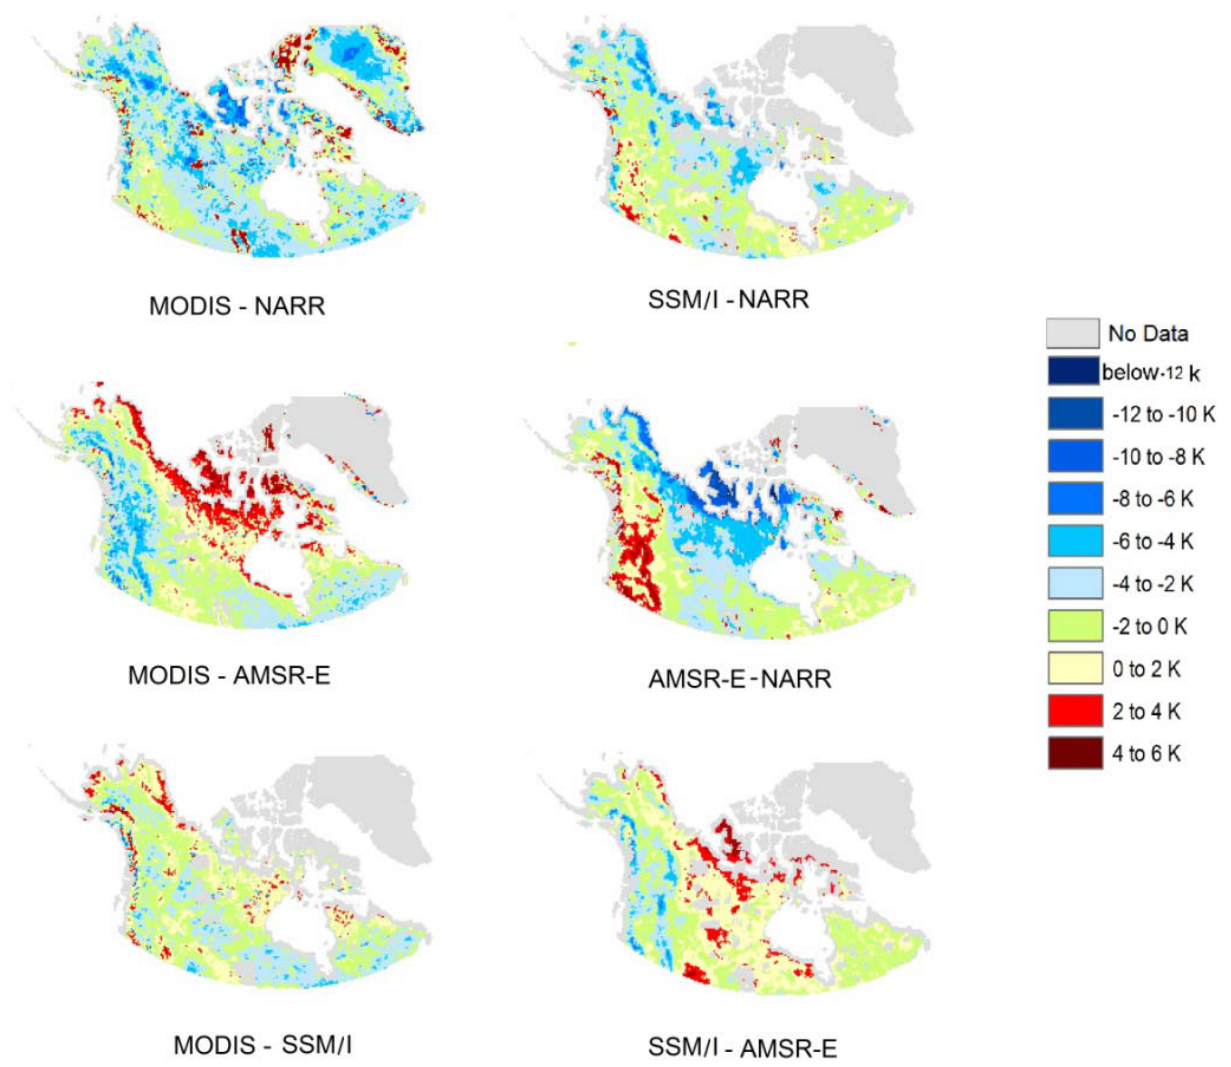
Figure 10. Bias maps derived from intercomparison between monthly UW-L3 of MODIS and clear-sky only monthly average of SSM/I, AMSR-E Ta and NARR temperature for the month of July 2007. SSM/I and MODIS were found to have the least contrasting bias zones when compared to